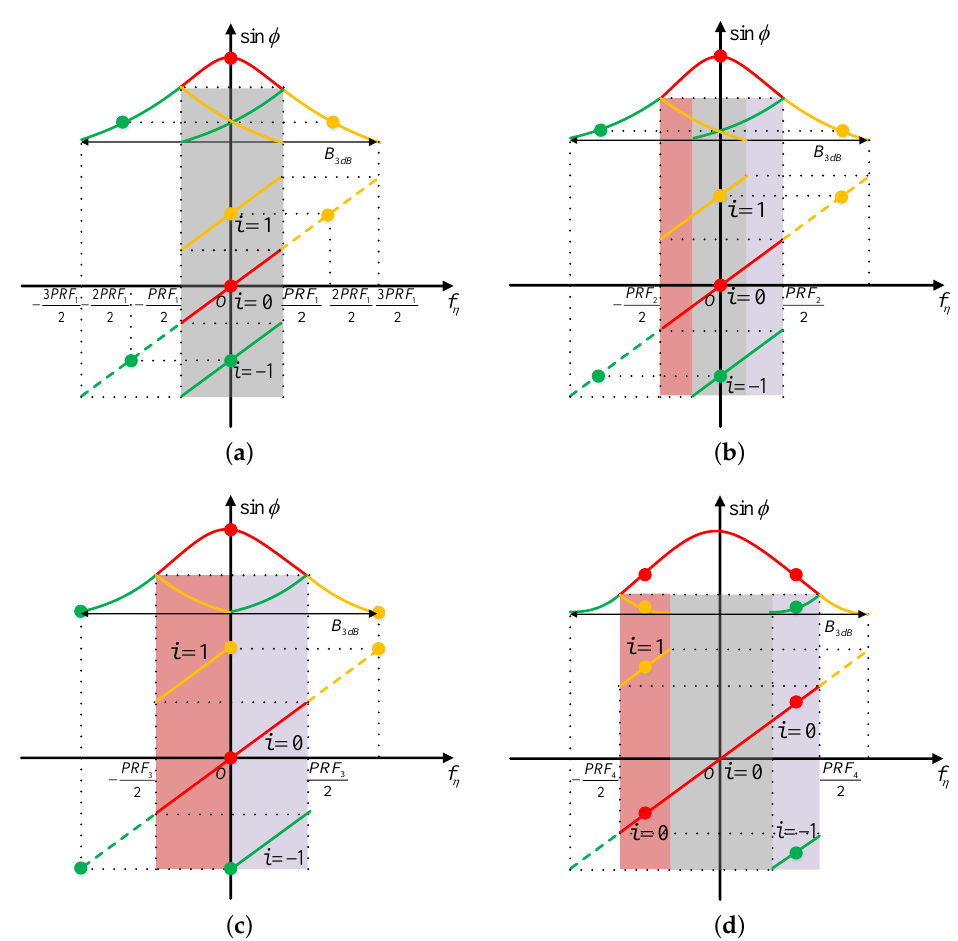
Figure 3. Doppler spectrum of ground echoes in a three-channel SAR system. ( a ) Uniform sampling. ( b ) Nonuniform sampling with spatial proximity of channels 1 and 3. ( c ) Nonuniform sampling with spatially coinciding samples of channels 1 and 3. ( d ) Nonuniform sampling with spatially interleaved samples of channels 1 and 3. The curved line represents the spectrum amplitude. The dotted line indicates that the Doppler is unambiguous while the shadow denotes that the Doppler is ambiguous due to azimuth undersampling. The line segments of three colors (yellow, red, and green) represent the spectrums with different index of ambiguity. The different shadows represent different distribution of ambiguity indexes in the Doppler